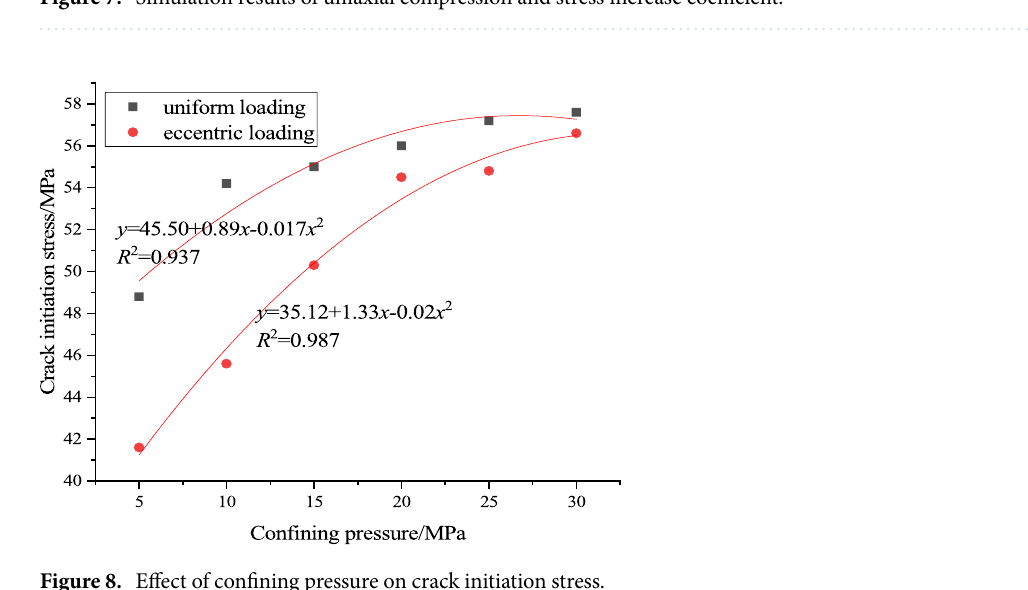
Figure 7. Simulation results of uniaxial compression and stress increase coefficient.